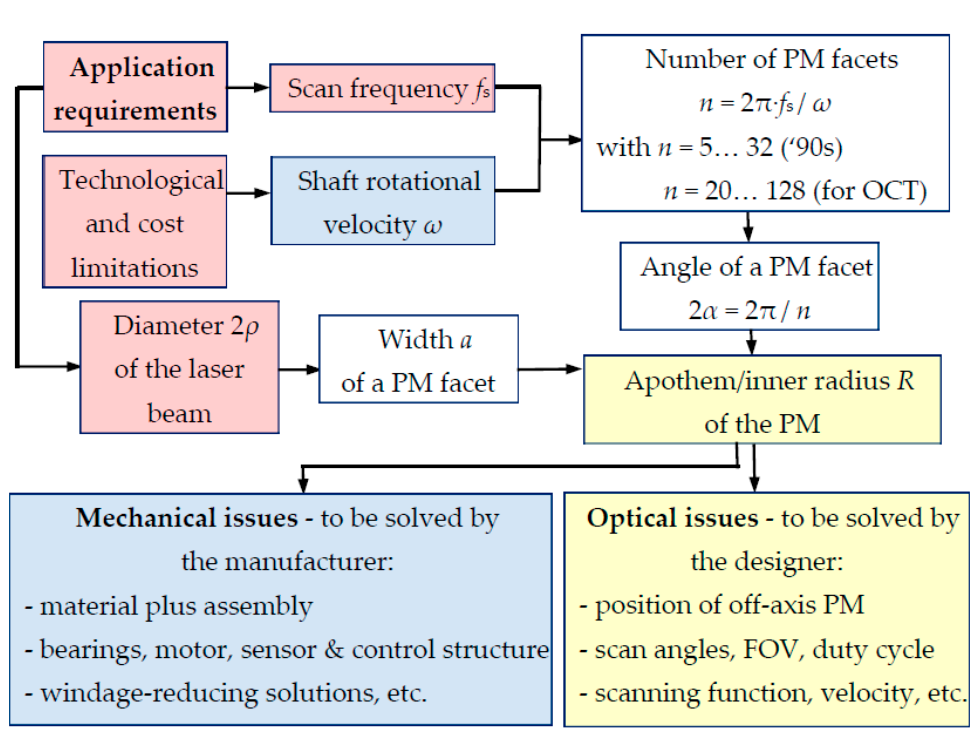
Figure 16. Optical scheme for dimensioning a PM—from the brief classical calculus in [1]—with optical and mechanical issues left to be solved by designers and manufacturers.